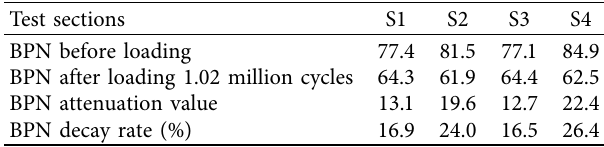
Table 6: BPN and loading cycles.